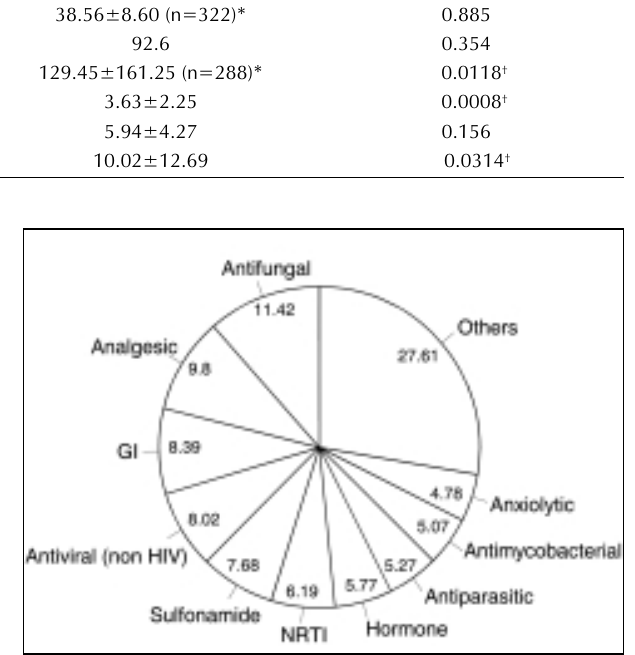
Figure 1) Drug classes taken before highly active antiretroviral ther- apy (phase 1). The percentage breakdown of medication classes